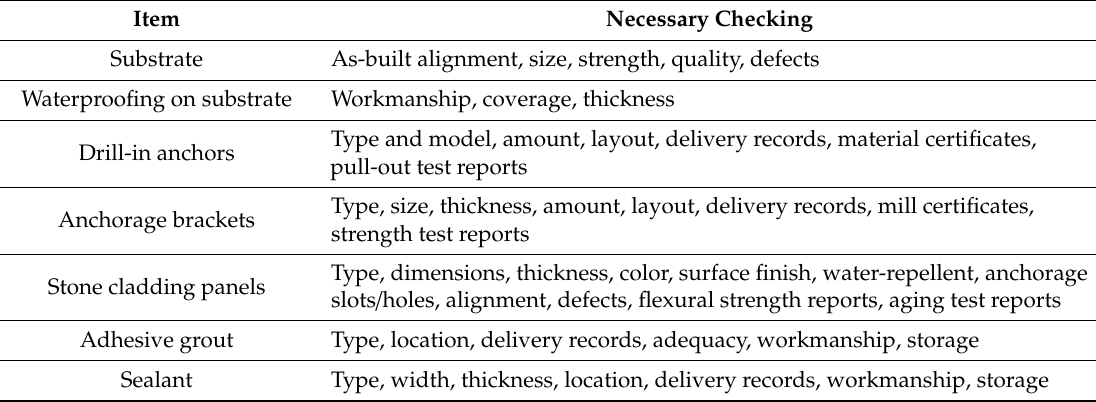
Table 5. Proposed items in the checklist for external stone cladding